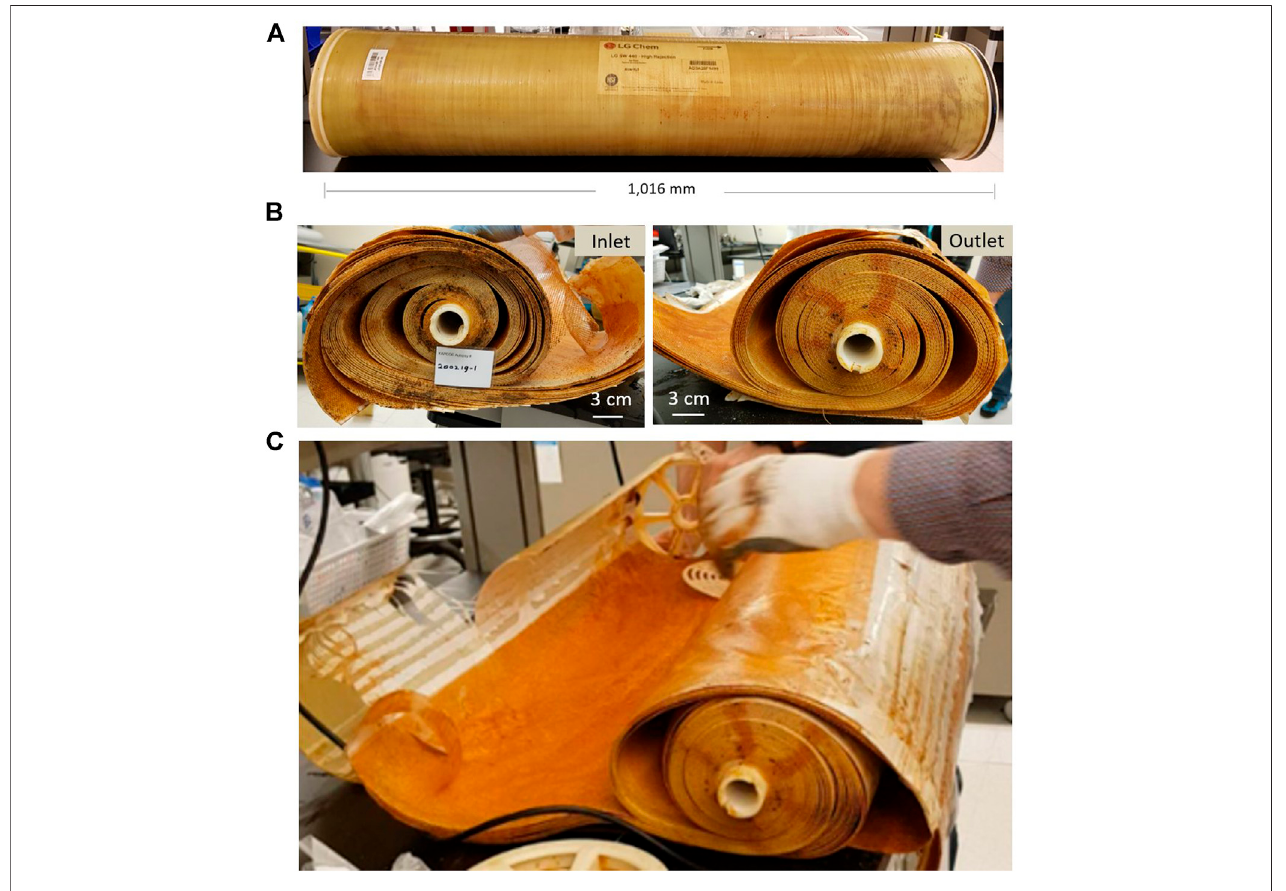
FIGURE3| Macroscopicstatusofthemembranemodule. (A) Intactmembranecase. (B) Frontalviewoftheinletandoutletafteropeningthemoduleandremoving the end-caps. (C) Unwound membrane sheet illustrating homogeneous coverage of the membrane sheet by orange-colored fouling material.